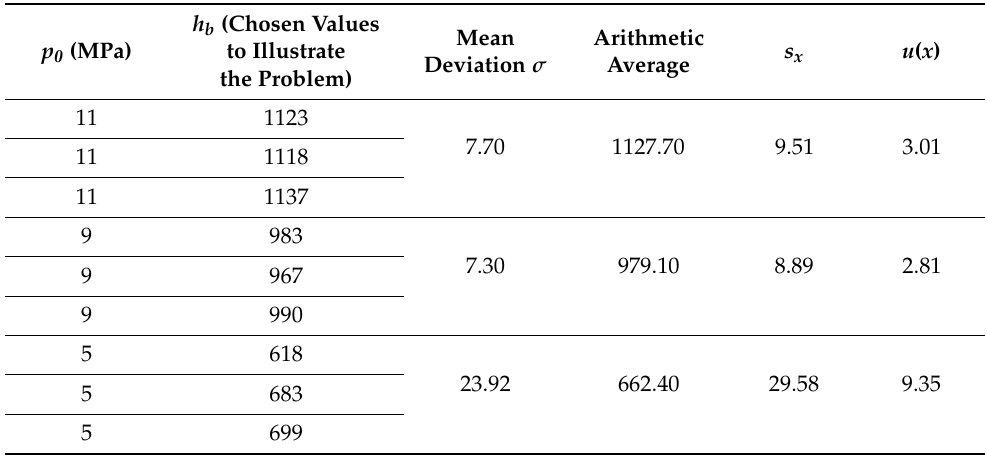
Table 2. Selected test results for the parameter h b , determined by mean deviation σ , arithmetic average, standard deviation estimator s x and measurement uncertainty u ( x